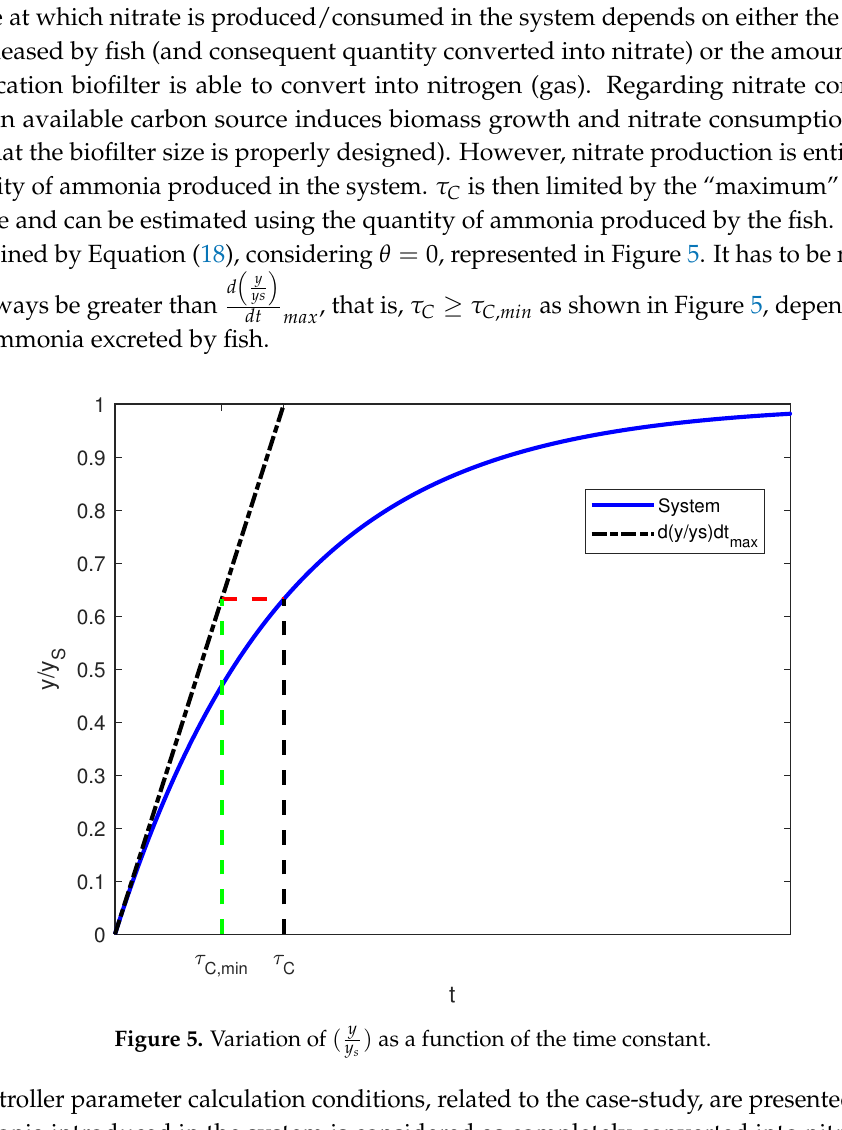
Figure 5. Variation of ( y